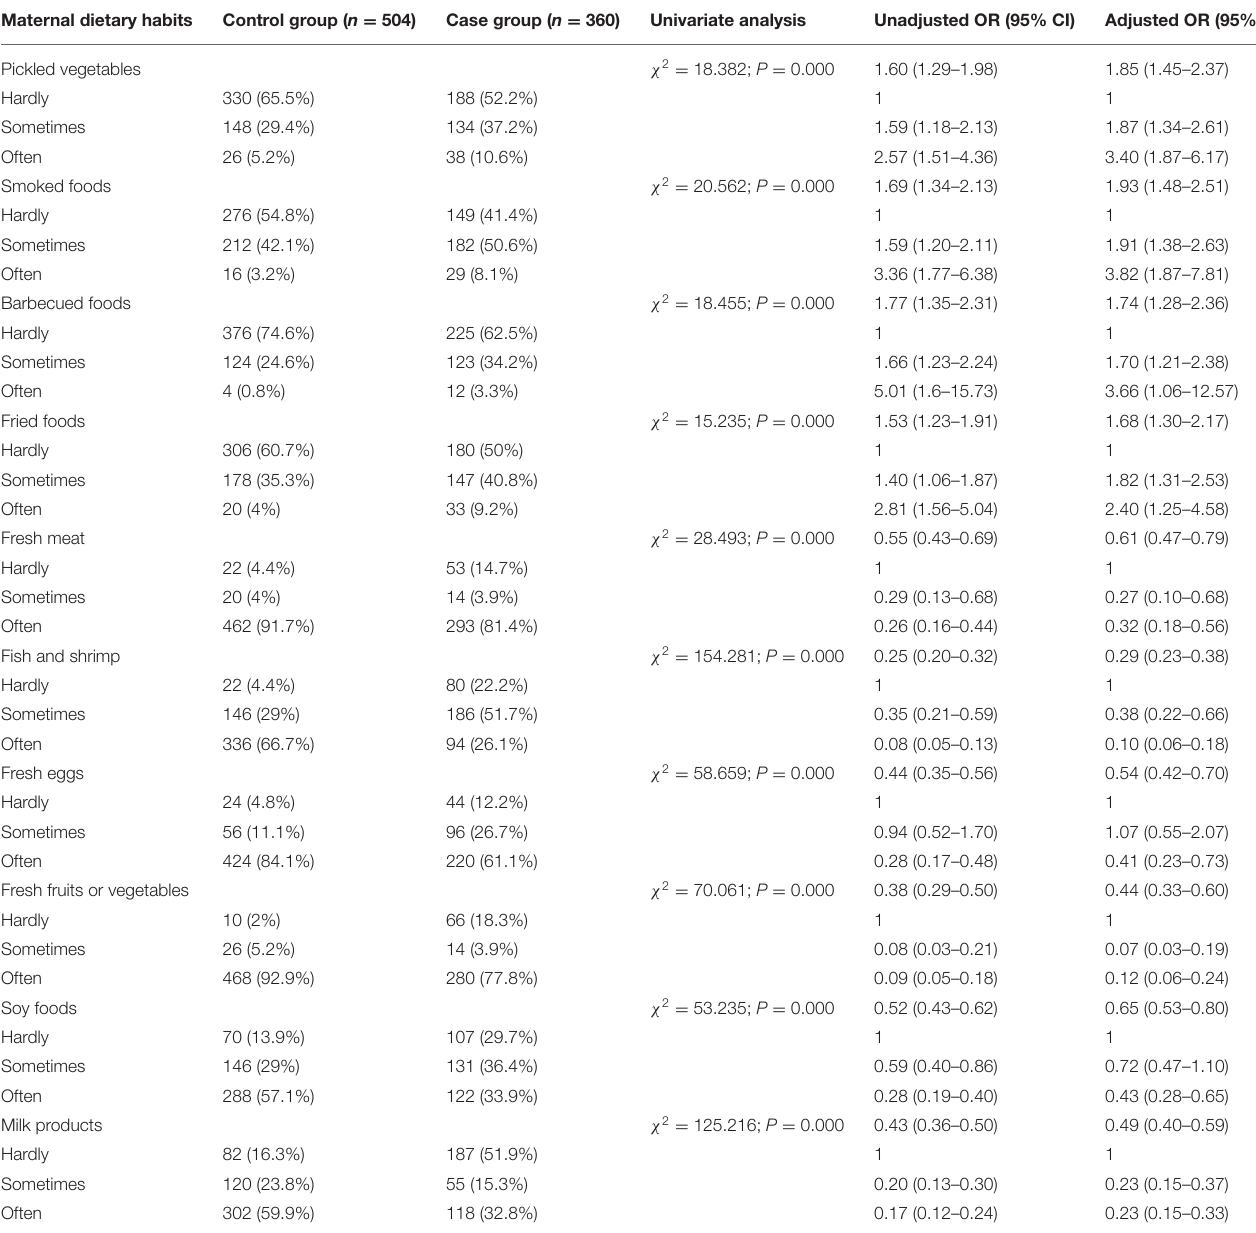
TABLE 2 | Maternal dietary habits and the risk of VSD in offspring a . Maternal dietary habits Control group ( n = 504) Case group ( n = 360) Univariate analysis Unadjusted OR (95% CI) Adjusted OR (95% CI)